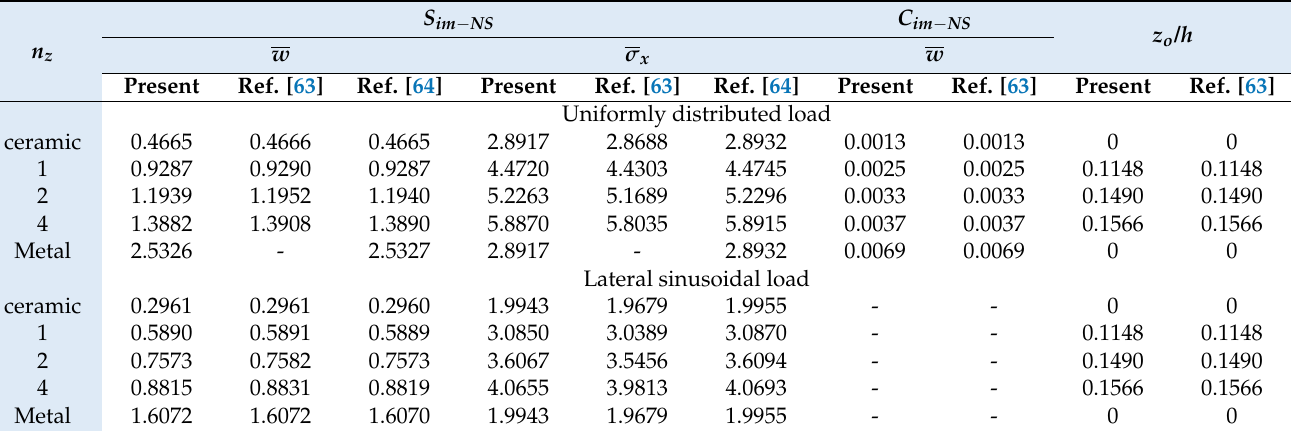
Table 1. Comparison of the non-dimensional maximum deflection ( w = w max 10 E c h 3 σ x ) of BDFG Al/Al 2 O 3 square plate ( a / h = 10) under uniform/sinusoidal transversal and ( σ x = h aq 0 load based on neutral surface formulation